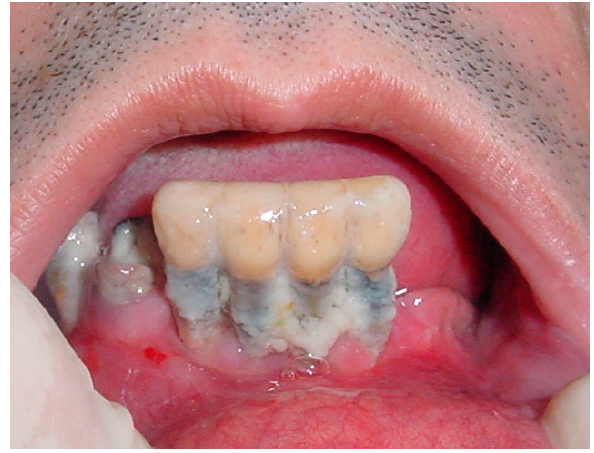
Figure 2. Severe periodontal disease and partial edentulism in subjects suffering from dementia. A marked clinically detectable reabsorption of bone crests was found in almost all patients